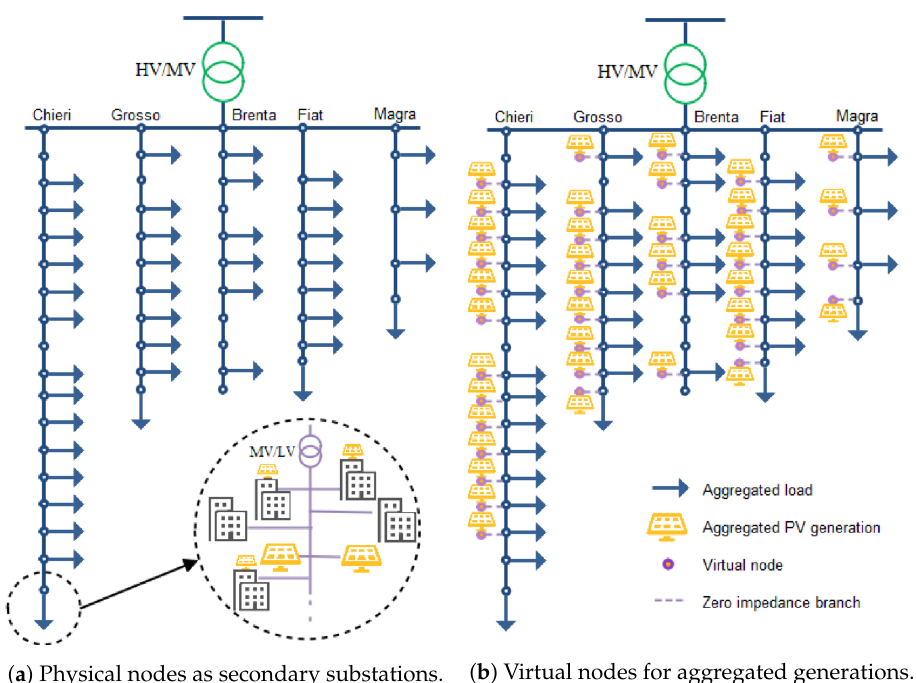
Figure 4. MV distribution system with high PV